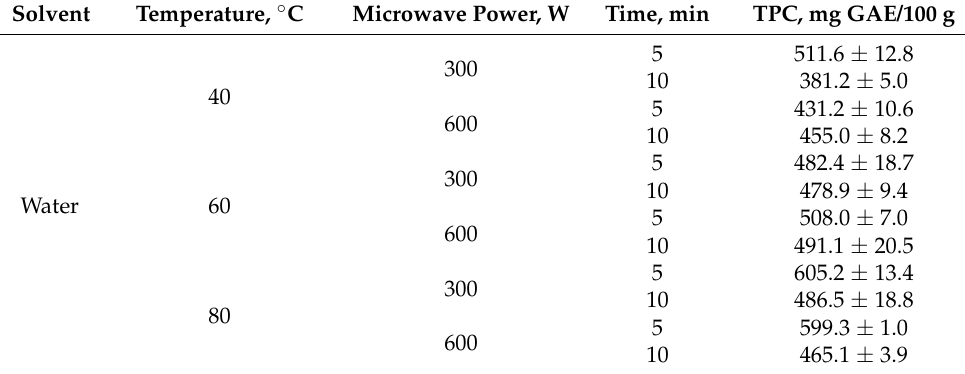
Table 1. TPC in fennel seeds extracts obtained under different conditions of MAE according to the full factorial